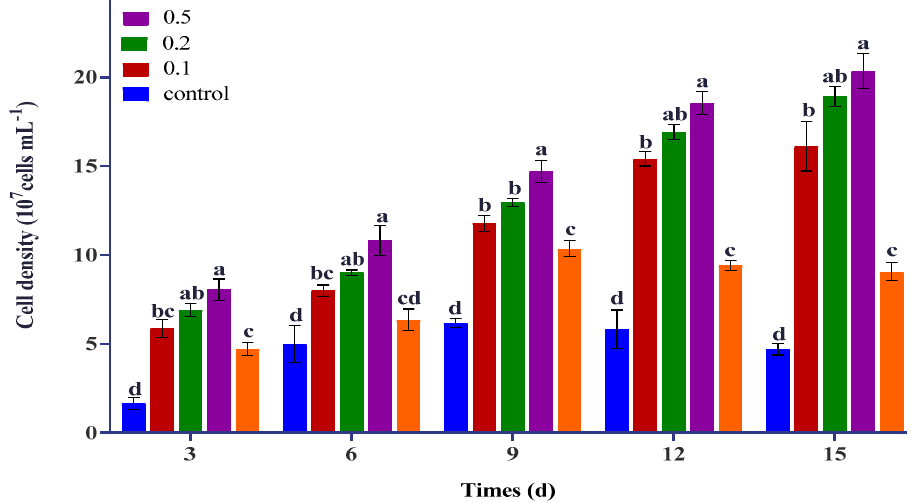
Figure 1. Effect of different concentrations of urea combined with kelp waste extract (KWE) on the cell density of C. sorokiniana . The bar charts represent the means ± SD of triplicate samples ( n = 3). Different alphabets letters indicate significant differences ( p < 0.05) between the urea concentrations.